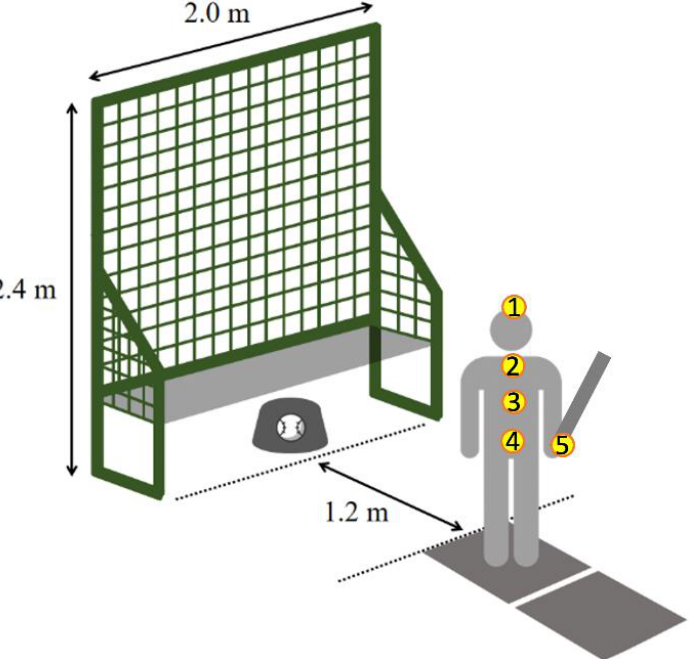
Figure 1. Experimental setting. Five circles represent the placements of five inertial measurement units (IMU). 1—head; 2—vertebra prominens (C7); 3—thoracic vertebrae 10 (T10); 4—sacrum; and 5—the bottom of the bat.